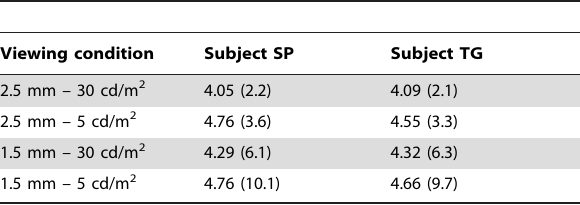
Table 2. N atural pupil diameter (in mm) of the dominant eye during Pulfrich